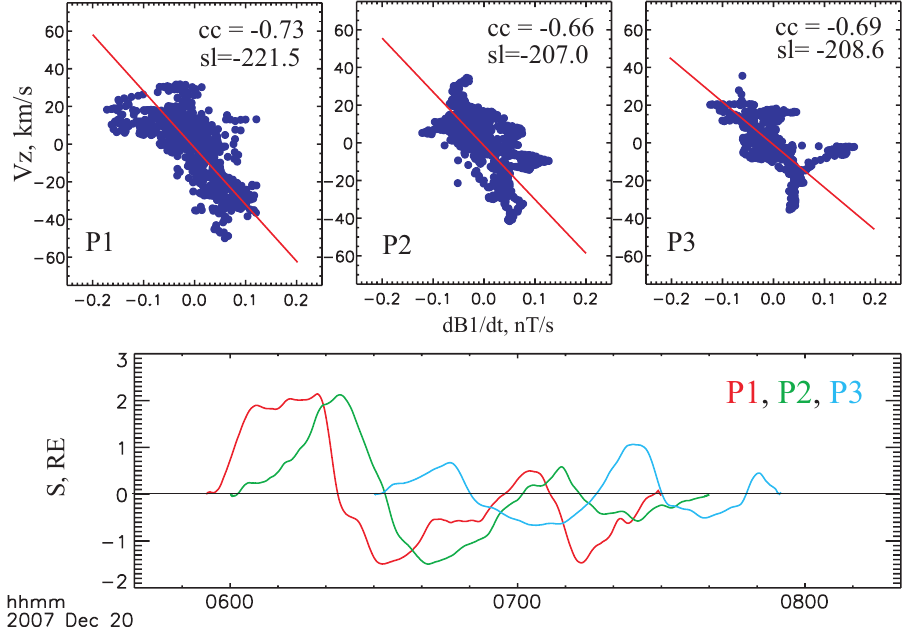
Fig. 7. Comparison of the main magnetic field variation rate ( ∂B 1 /∂t ) and the vertical bulk velocity ( V z ) at P1, P2, and P3 during flapping intervals (upper row). Integrated V z versus UT (bottom